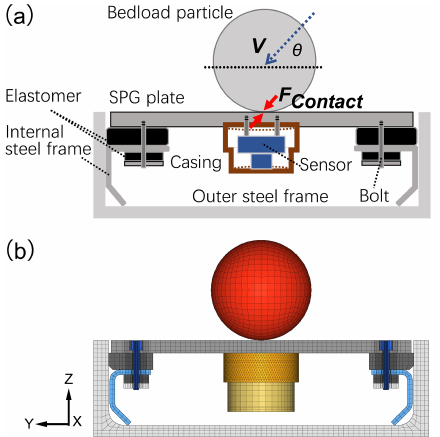
Figure 2. (a) Cross-sectional sketch of the SPG system impacted by a spherical particle. (b) Cross-sectional view of the FEM model of the SPG system. The coordinate system is set up with the X axis pointing in the transverse direction (across the flume width), the Y axis pointing downstream (in the flow direction), and the Z axis pointing up perpendicular to the plate’s surface. θ is the impact an- gle of the sphere. F Contact is the contact force between the sphere and the plate. V is the impact velocity of the sphere onto the plate, which has two components V Y and V Z (given in Table 4). Table 4. Characteristic values of the spheres and impact angles used in the FEM simulations. The diameters D 1 , D 2 , and D 3 of the spheres are 82, 95.5, and 120mm, respectively. A constant den- sity ρ s = 2677kgm − 3 was used in the FEM simulations. V Y and V Z are the components of the impact velocity in the Y and Z direc- tions, respectively.